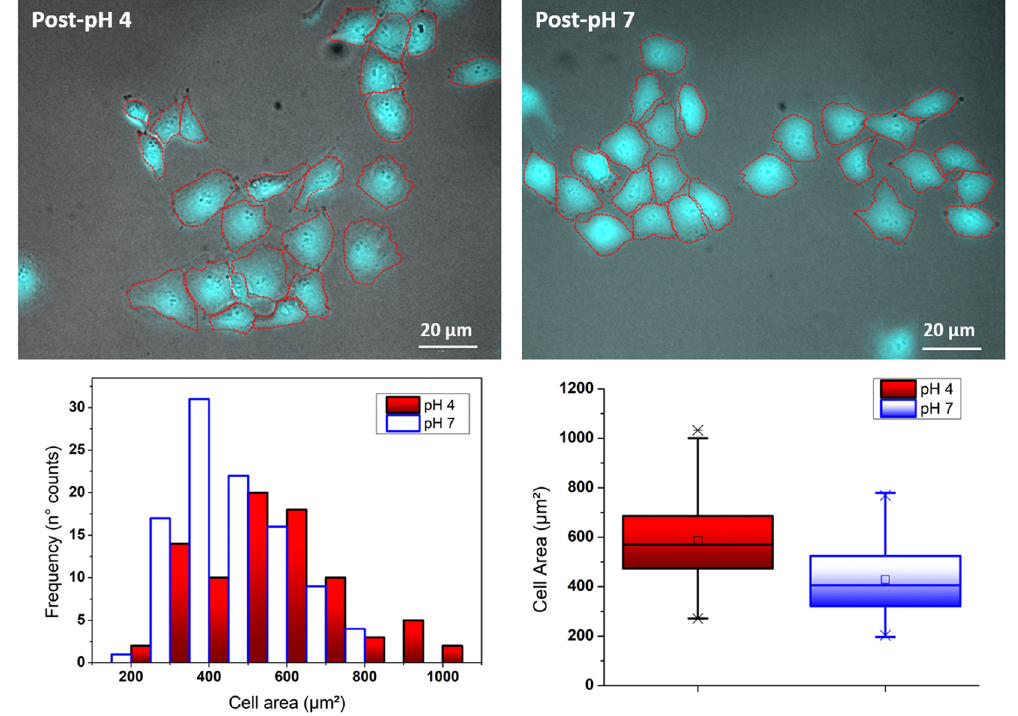
Figure 6. HUVEC cells on pH-treated mucin films after 24 h of incubation. Red lines highlight the cell profiles for a better viewing. Statistical analysis below show the individual cell area distribution in the shape of both histograms and boxplots. In the latter, the square ( □ ) in the box plot represents the mean value, the box- splitting horizontal line gives the median, and the upper and lower value are indicative of the achievement of either the 99% or 1% of the population,